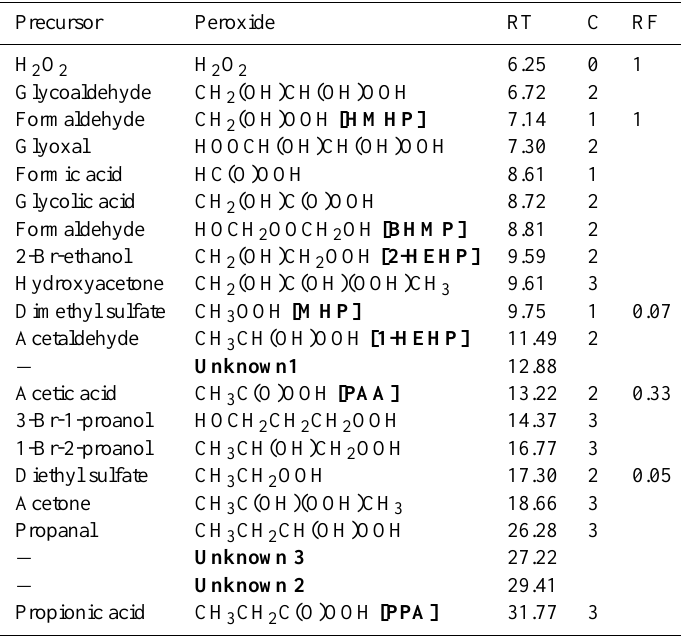
Table 2. Synthesized peroxides and their retention time, carbon number, and response factors. H 2 O 2 and the three unknown peroxides are listed for